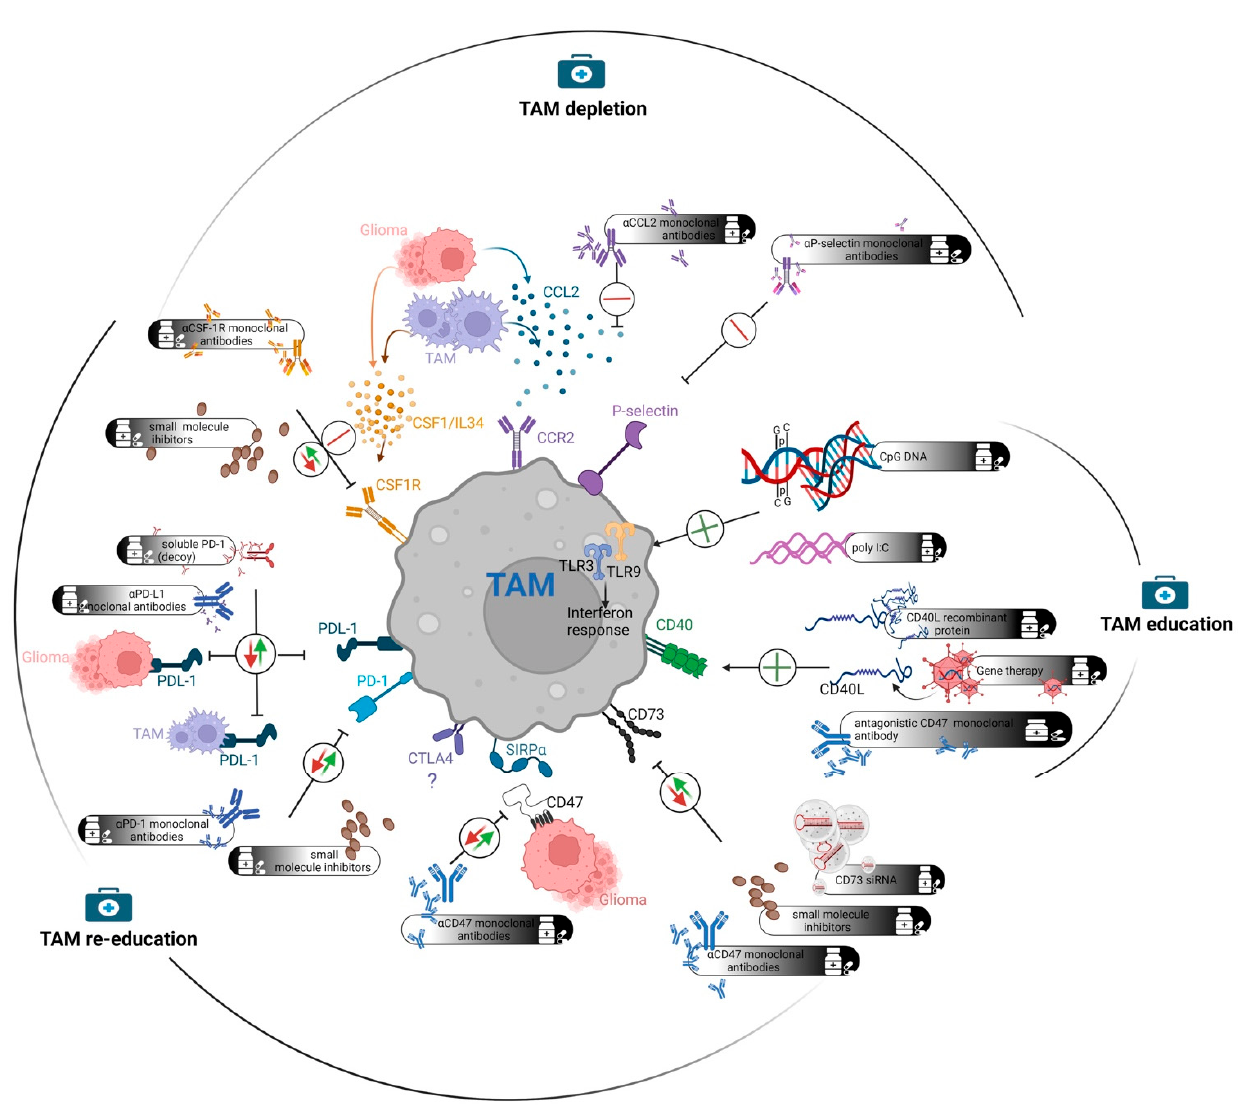
Figure 1. Targeting TAMs in GBM. Strategies of targeting TAMs can be categorized into three distinct approaches. TAM re-education involves targeting the immune checkpoints that provoke an immuno- suppressive M2 phenotype. ICI regimens belong to this category. Depending on the glioma model used, CSF1R-inhibition demonstrates either TAM-reprogramming or depleting capabilities. TAM education activates the pro-inflammatory machineries of myeloid cells that can promote phagocytic activity, antigen presentation and the secretion of an array of immune-activating cytokines. TAM depletion targets the ligands and receptors that are involved in macrophage/monocyte infiltration from the periphery. These approaches are not mutually exclusive in a clinical setting. Particular combinations, which need to be tested more thoroughly in the future, could potentially lead to a better